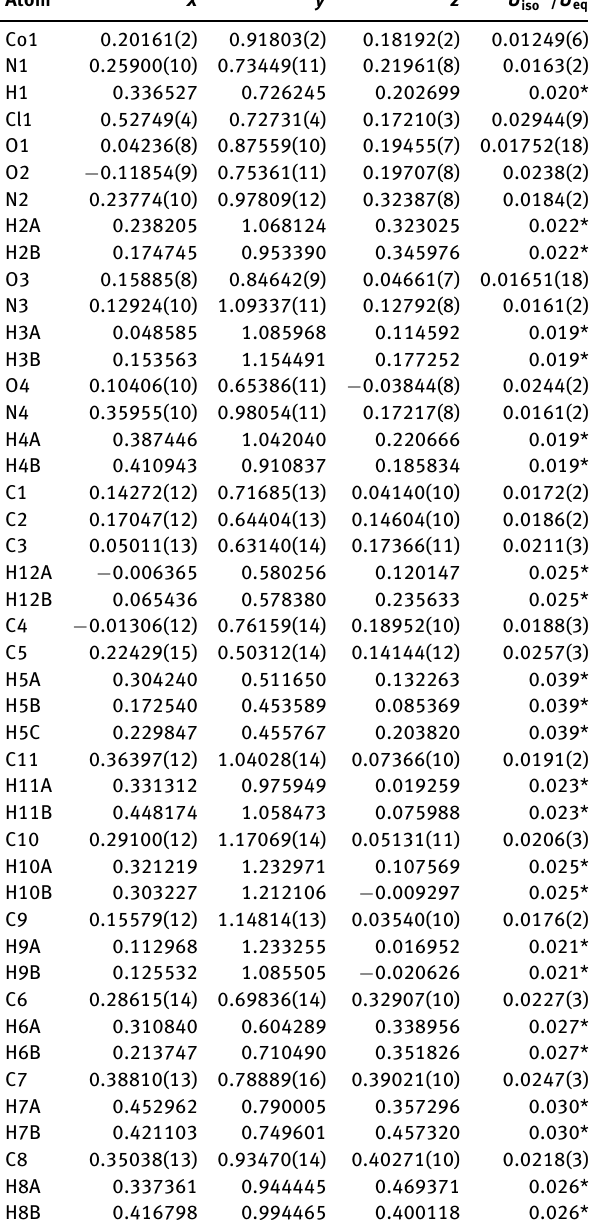
Table 2: Fractional atomic coordinates and isotropic or equivalent isotropic displacement parameters (Å 2